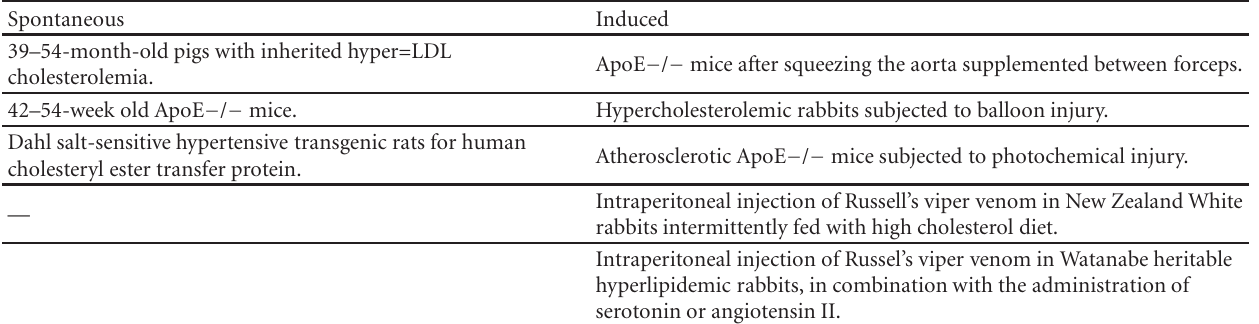
Table 2: Animal models of plaque rupture and plaque associated